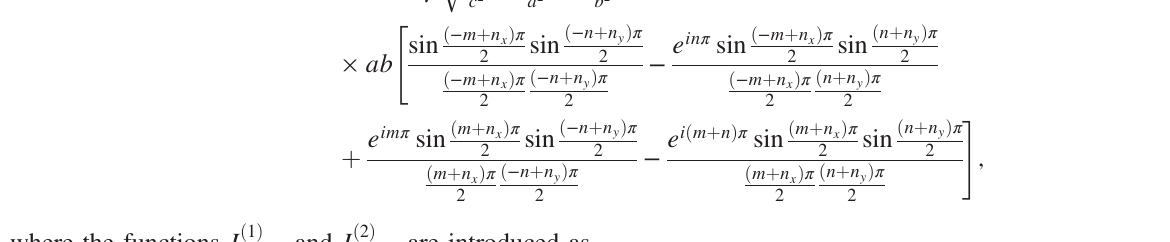
ffiffiffiffiffiffiffiffiffiffiffiffiffiffiffiffiffiffiffiffiffiffiffiffiffiffiffiffiffi